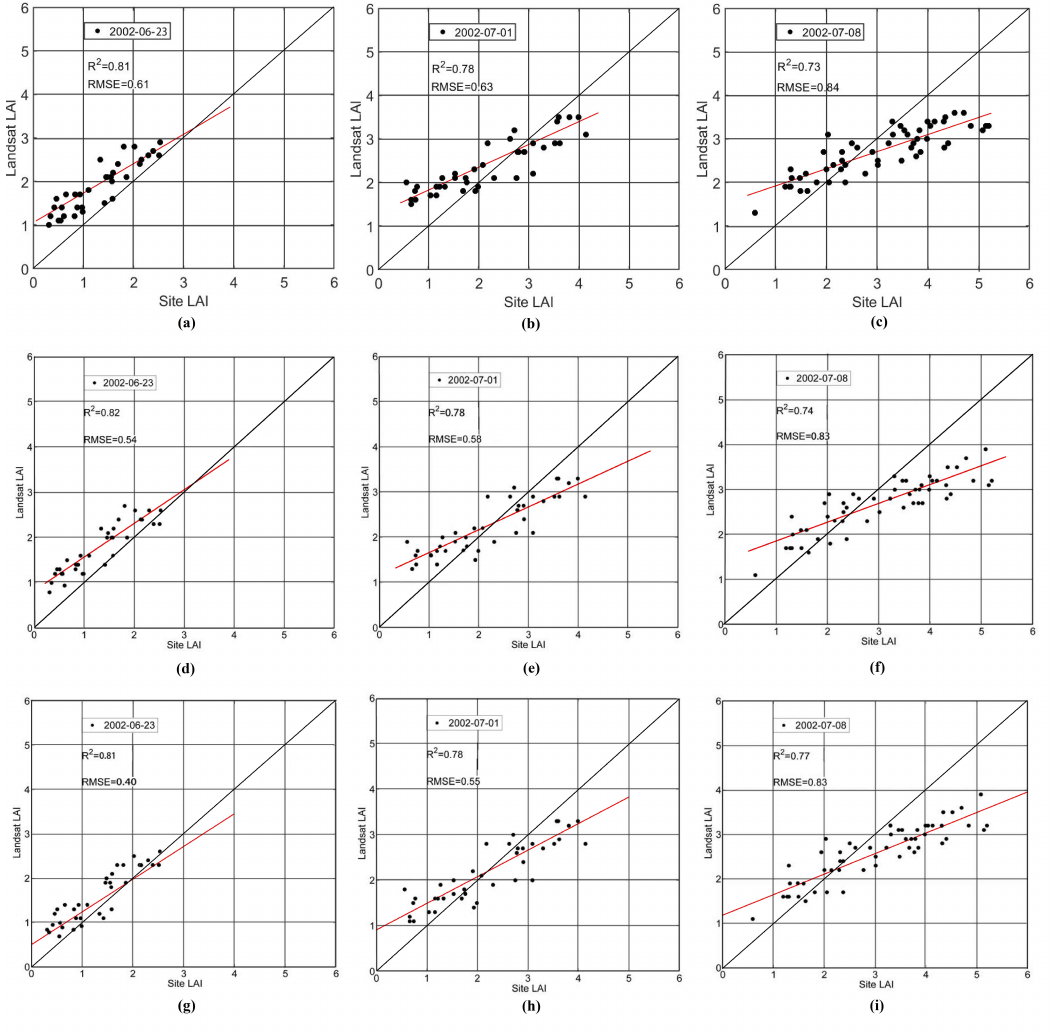
Figure 6. Comparison of inversion LAI in time series with field measurements. ( a – c ) The results of dataset A1; ( d – f ) the results of dataset A2; ( g – i ) the results of dataset